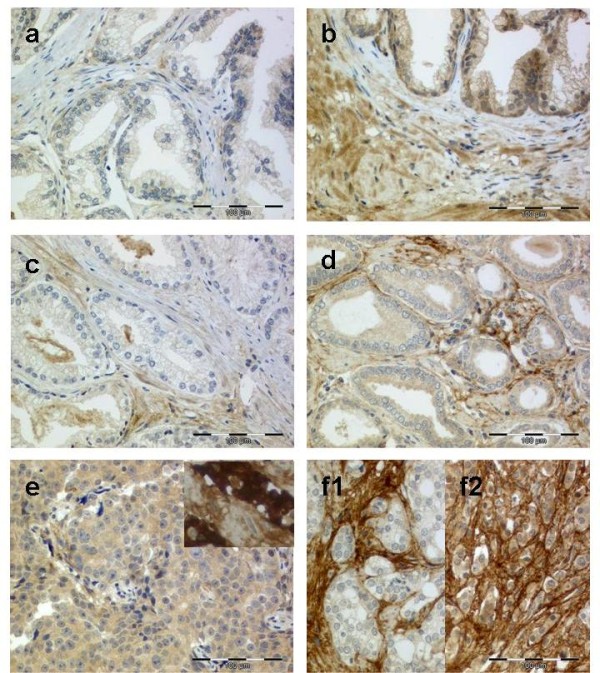
Periostin protein expression in malignant and benign prostate tissue. Weak (a) to moderate (b) epithelial and negative (a) to weak (b) stromal periostin expression in benign prostate glands. In contrast to most cancer cases, in benign tissue with stromal periostin expression the direct periglandular area is rather negative. Some cases showed a weak periostin positivity of basal cells. Prostate cancers with negative (c), weak (d), moderate (e/f2) and strong (e inset) epithelial periostin expression. The peritumoural stroma was weakly (c), moderately (d) or strongly (f1/f2) positive.